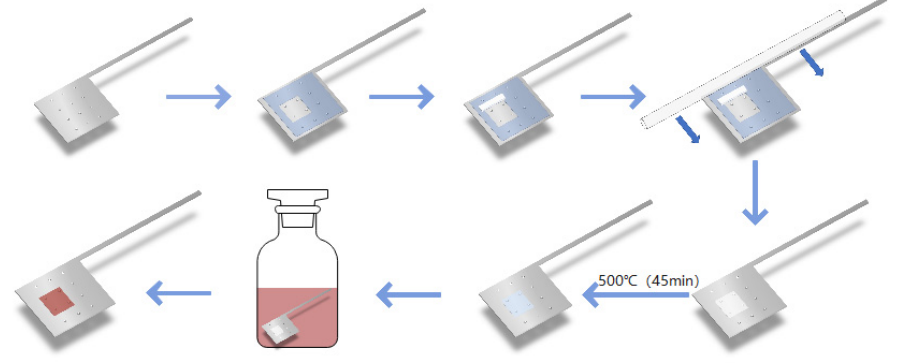
Figure 2. Photoanode preparation process.